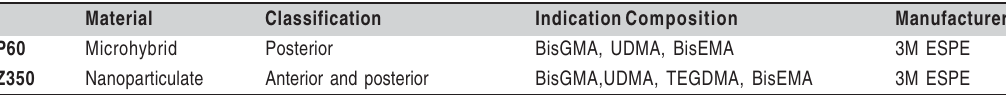
Table 1: Specifications of composite resins used